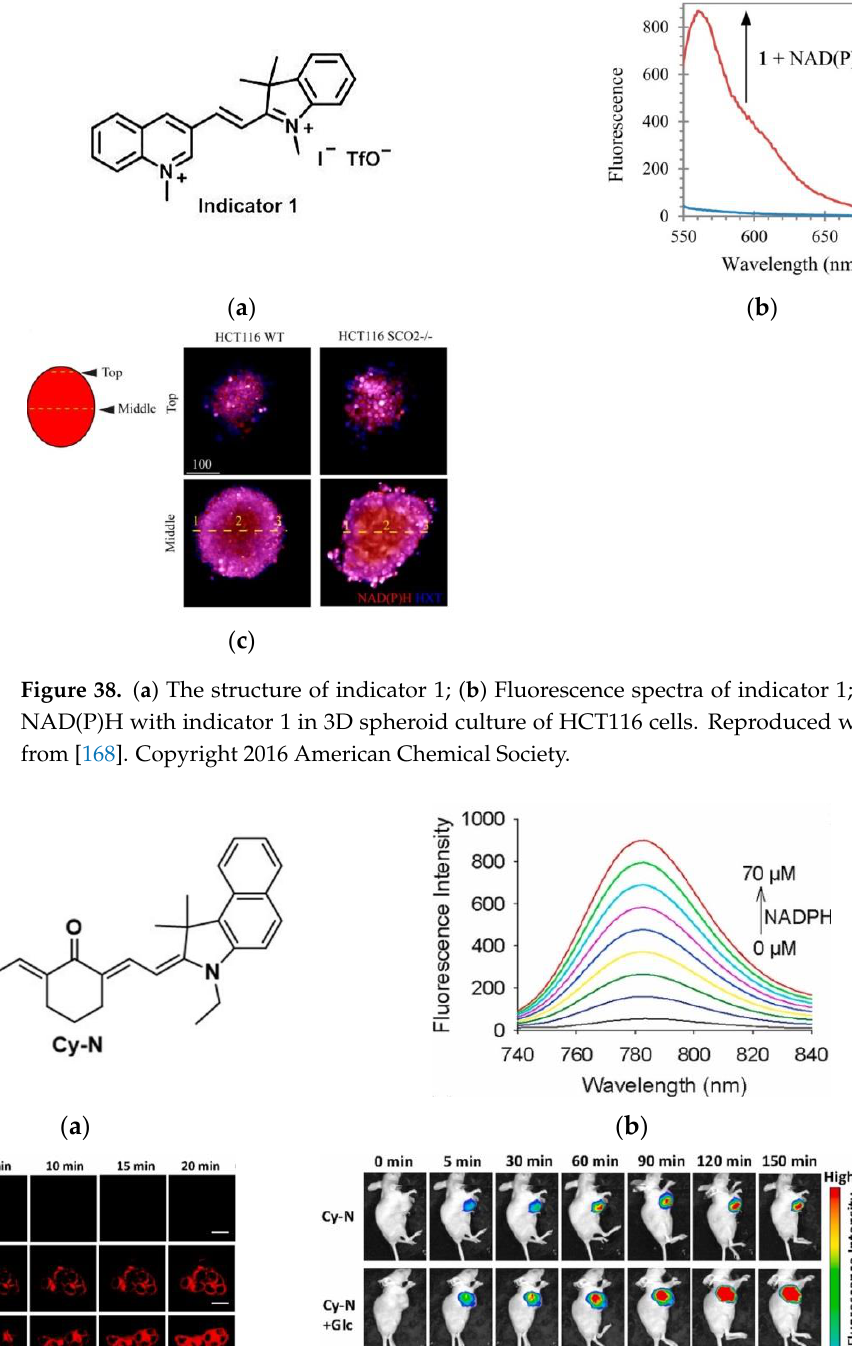
Figure 38. ( a ) The structure of indicator 1; ( b ) Fluorescence spectra of indicator 1; ( c ) Staining of NAD(P)H with indicator 1 in 3D spheroid culture of HCT116 cells. Reproduced with permission from [168]. Copyright 2016 American Chemical Society.